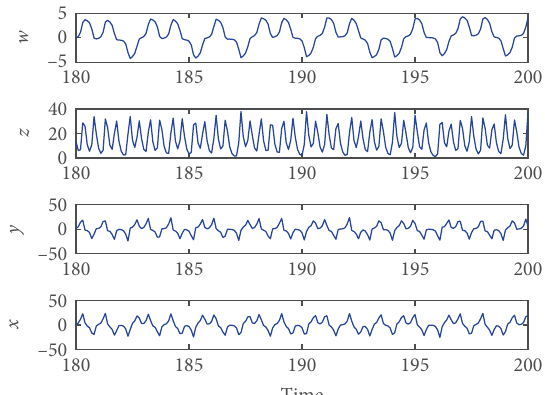
Figure 8: Time domain waveform of 𝑥 , 𝑦 and 𝑤 .